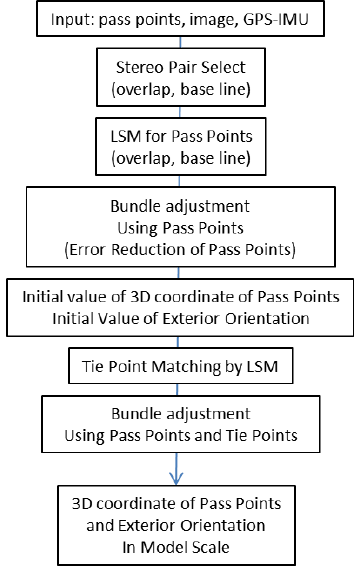
Figure 5. Processing flow of Tie Point Matching and Bundle Adjustment in Model Scale